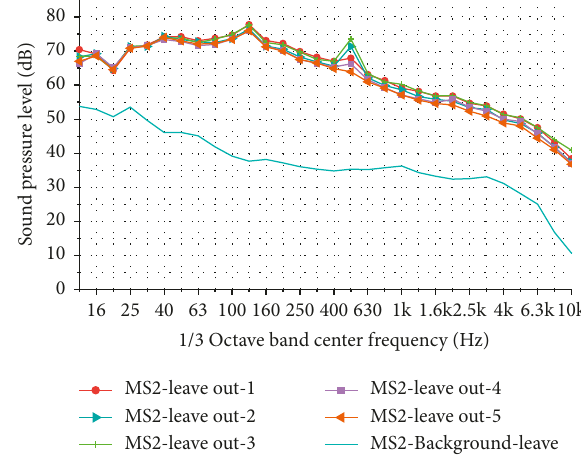
Figure 10: 1/3 octave frequency spectrum for measurement points